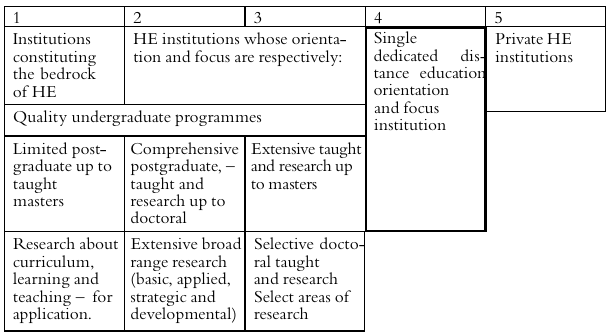
Figure1: Graphicillustrationofthenewrecon¢guredhighereducationsystemasproposed bythe Councilon Higher Education, ShapeandSizeof Higher